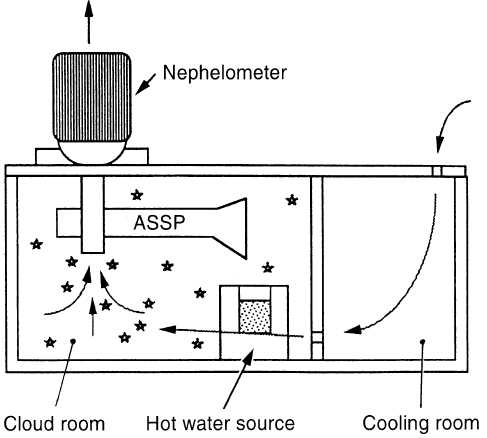
Fig. 14. Sketch of the cold chamber operated for